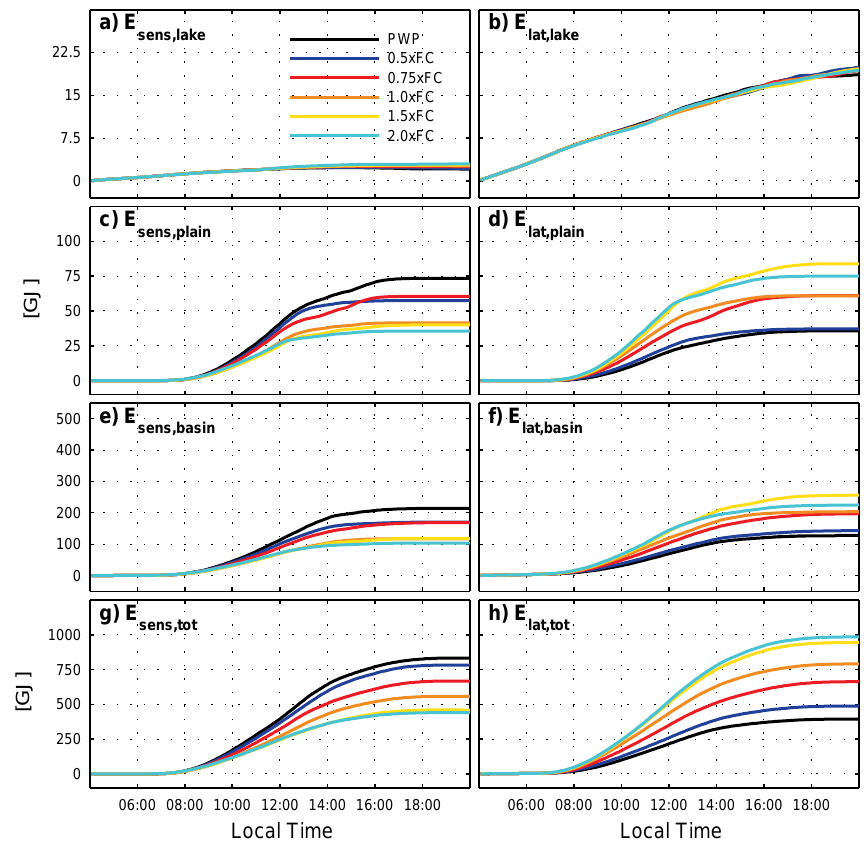
Figure 7. Spatially and temporally integrated turbulent energy fluxes ( E ) at Nam Co Lake for cases PWP, 0.5 × FC, 0.75 × FC, 1.0 × FC, 1.5 × FC and 2.0 × FC on 17 July 2012: (a, b) sensible and latent energy over the lake, (c, d) over the plain adjacent to the lake, (e, f) the Nam Co Basin as defined in the text and (g, h) in total